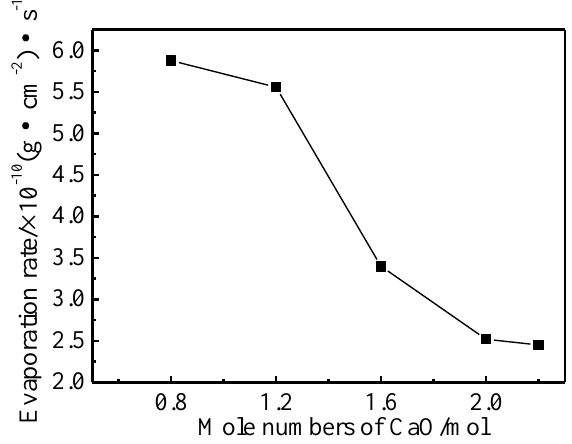
Figure 7. Average evaporation rate diagram of cathodes filled with 6BaO·xCaO·2Al 2 O 3 aluminates.